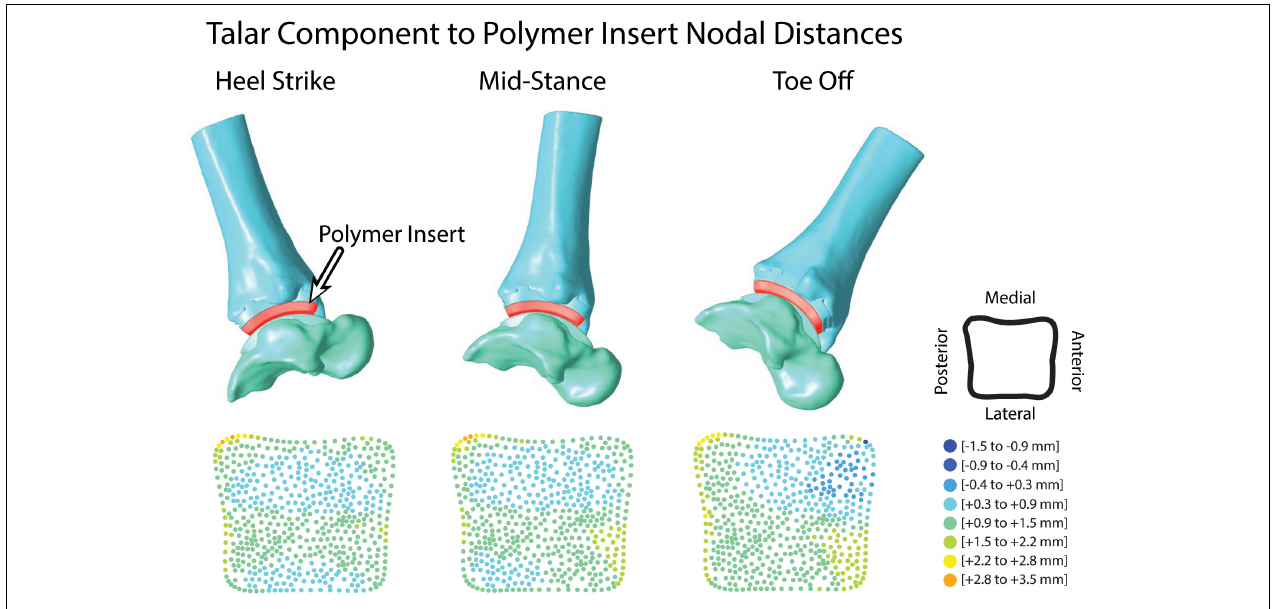
FIGURE 9 | Hybrid models from hybrid model tracking solutions during walking with polymer insert shown in red. 3D model positions from MBT solutions shown at heel strike, mid-stance and toe off with corresponding distance maps of the articular surface relationship between the polymer insert and talar implant.